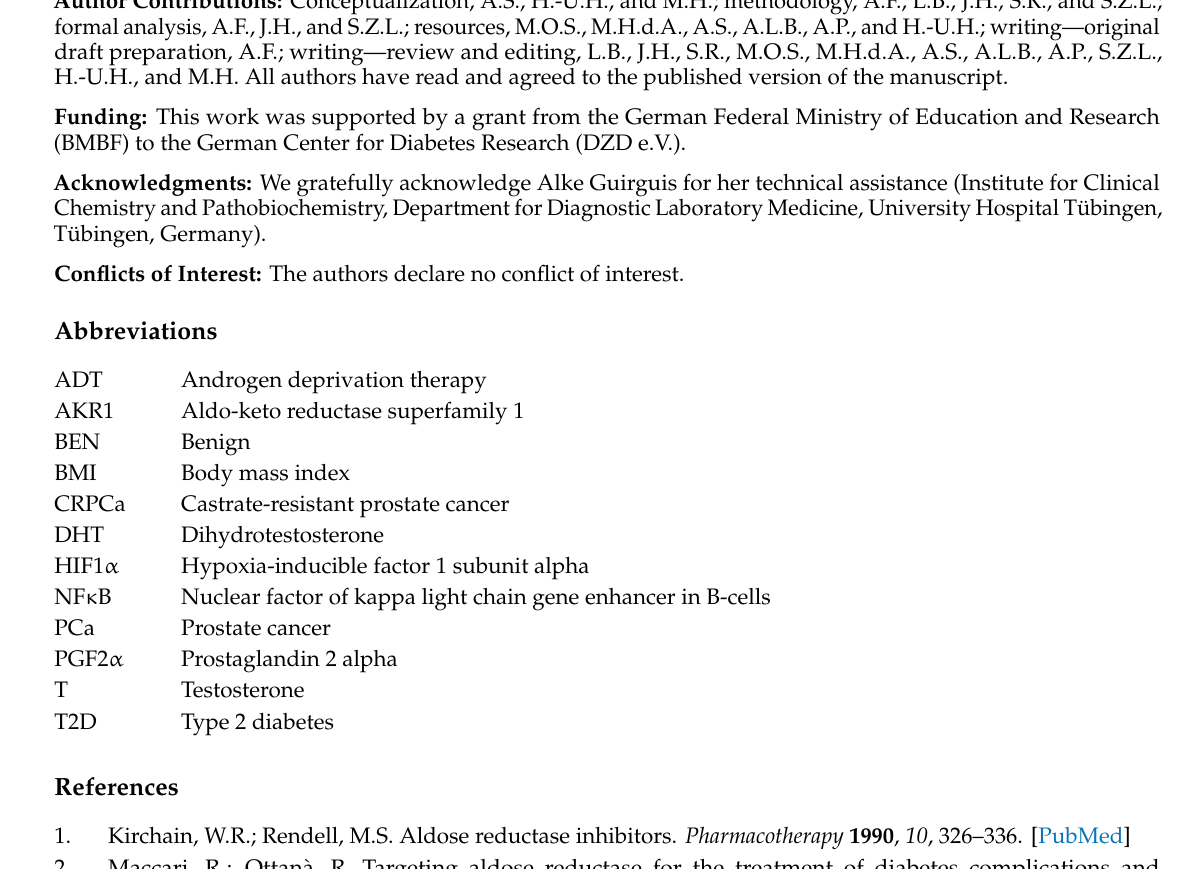
Figure S1: Gene expression of AKR1B1 in human prostate and PC3 samples; Table S1: Patient characteristics; Table S2: Gene expressions of proliferation processes and HIF1 α and NF κ B pathways in human prostate